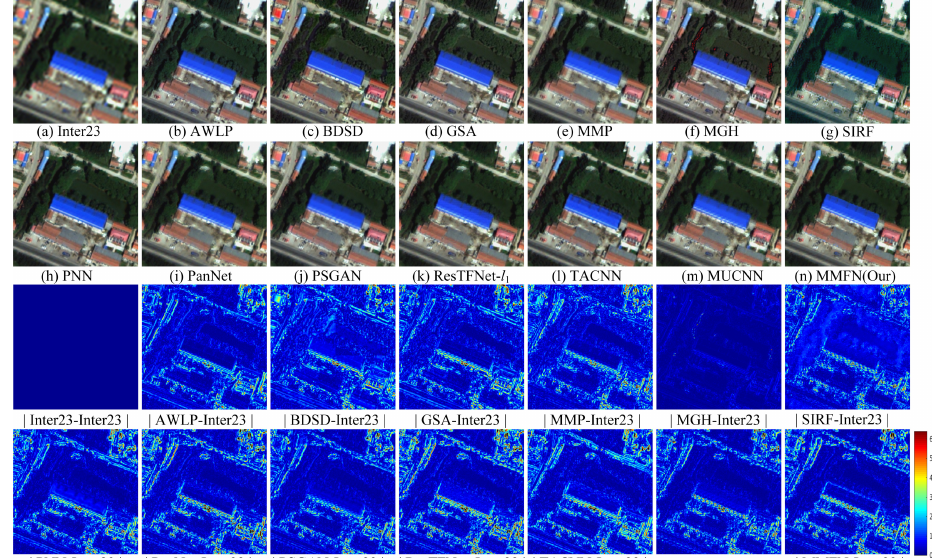
Figure 8. Qualitative comparison at full resolution on the WorldView-2 dataset. ( a ) Inter23, ( b ) AWLP,